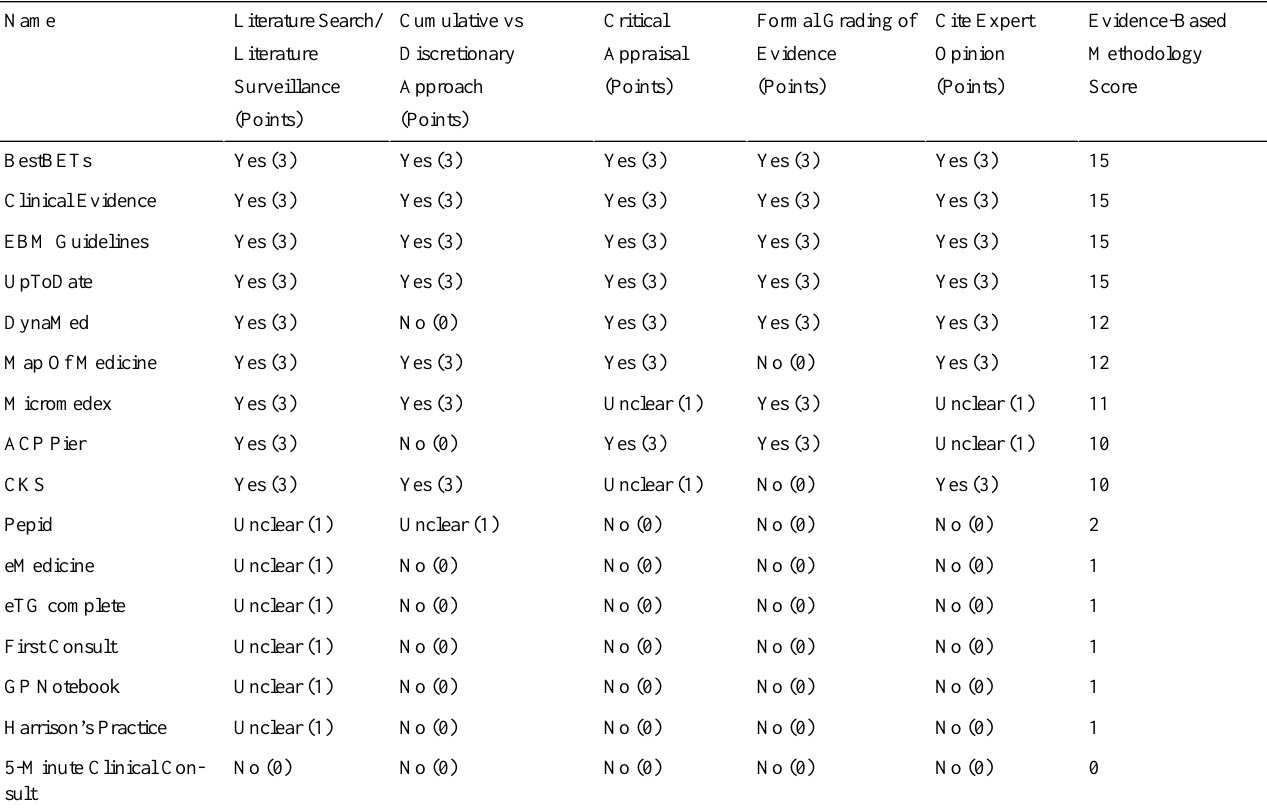
Table 5. Evidence-based methodology of EBP point-of-care summary